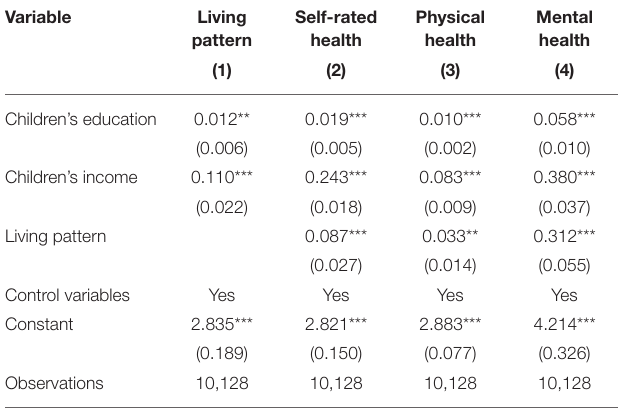
TABLE 4 | Analysis of multiple mediation effect of housing arrangement. TABLE 5 | Analysis of multiple mediation effect of children’ financial support to their parents.